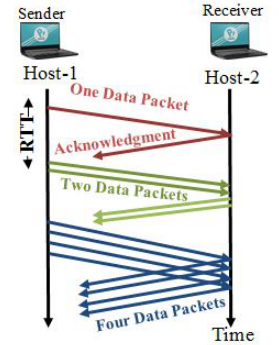
Fig. 1. Example of an adaptive sliding window for flow control